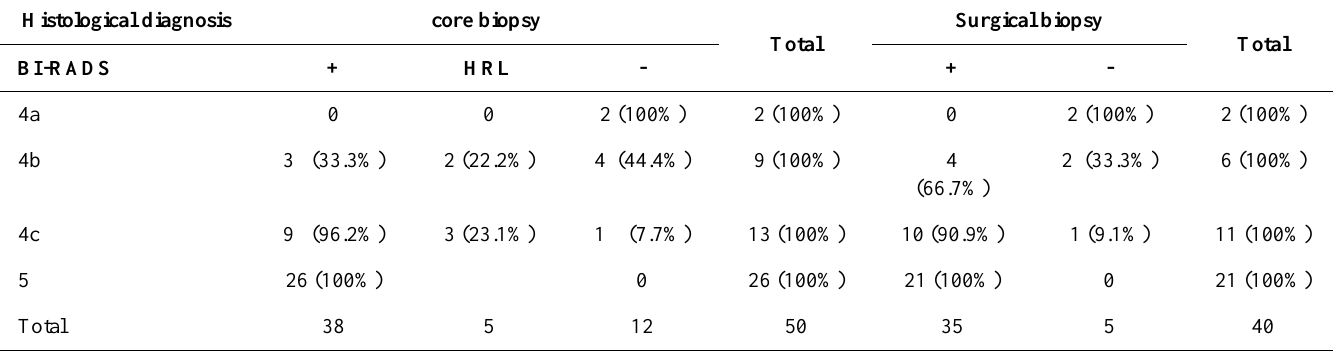
Table 4: Cross tabulation of Core and surgical histology diagnosis in relation to BI-RADS categories: Histological diagnosis core biopsy